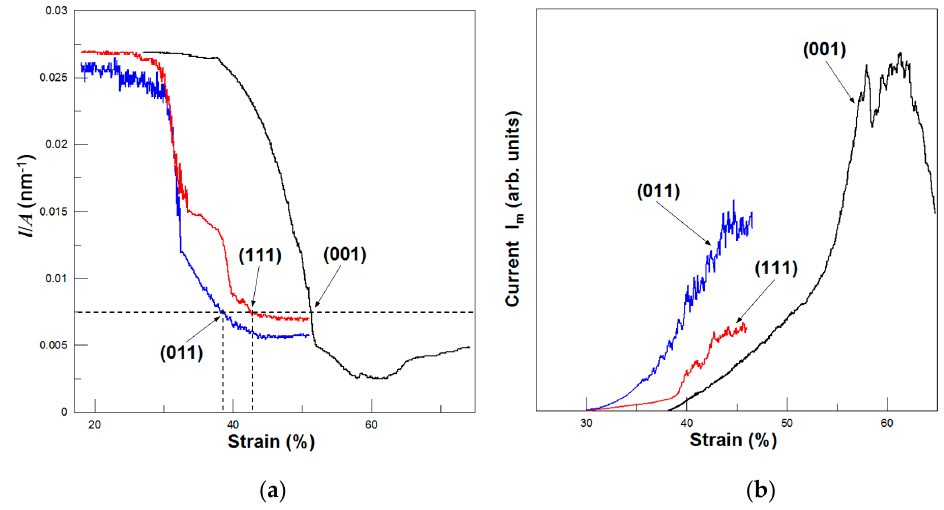
Figure 13. Resistance and current versus tensile strain of SiNW ( a ) resistance-strain curves; ( b ) current-strain curves.